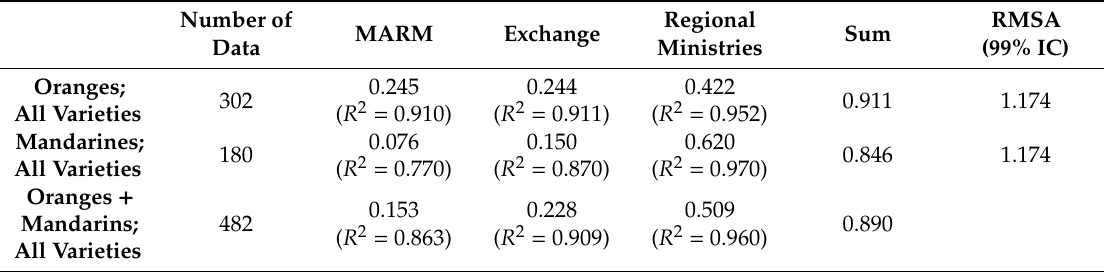
Table 5. Results for the aggregation of the varieties of oranges, mandarins, and joint